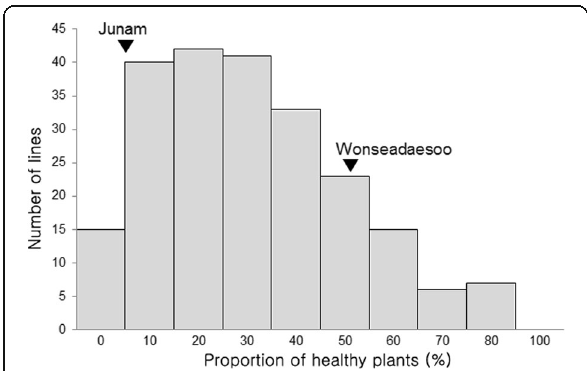
Fig. 3 Frequency distribution of the proportion of healthy plants ( n =200) in 200 F 4 recombinant inbred lines